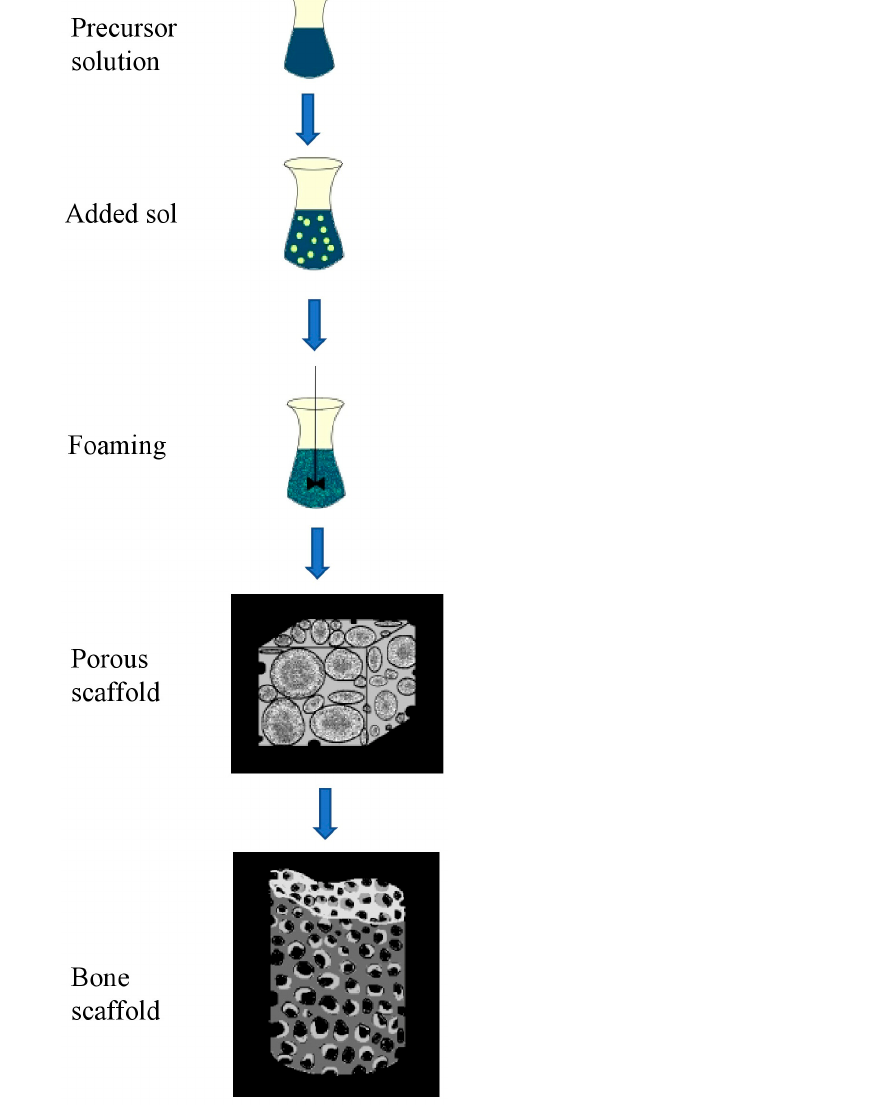
Figure 7. Schematic diagrammatic representation for designing bone scaffolds with hierarchical structures for bone regeneration using the sol–gel technique method.